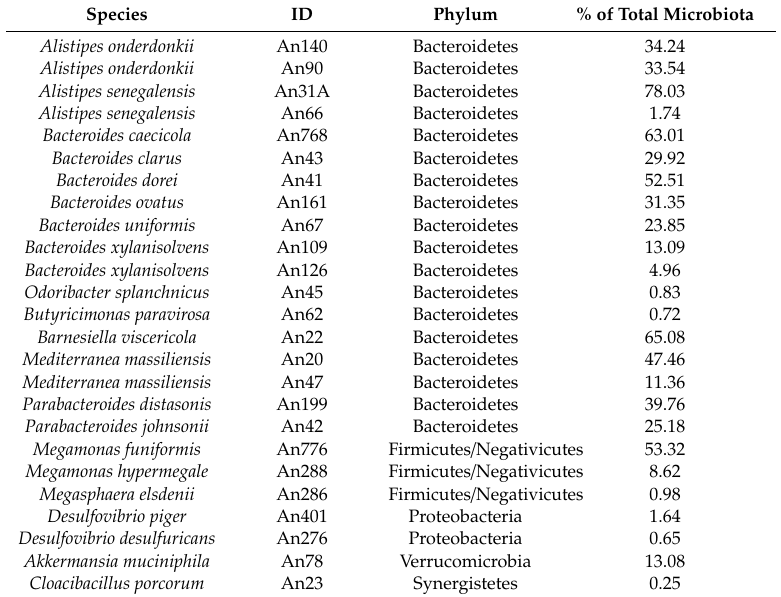
Table 1. List of isolates capable of colonising the chick caecum during the first week of life. Species ID